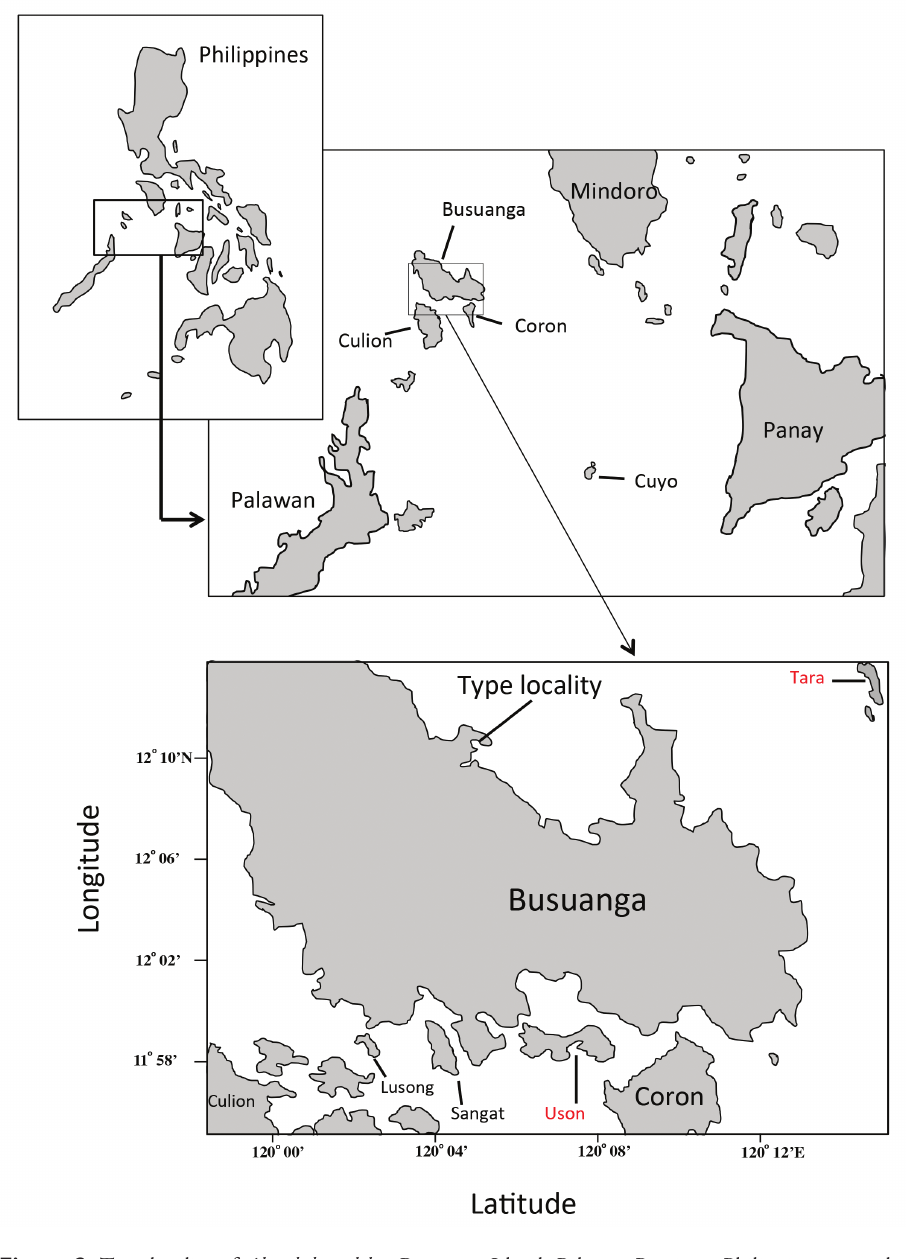
Figure 2. Type locality of Altrichthys alelia . Busuanga Island, Palawan Province, Philippines, near the village of Maricaban, next to the resort “El Rio y Mar”, 12.1911°N; 120.1022°E. Highlighted in red are Tara Island and Uson Island, where specimens of Altrichthys were first collected, as well as Uson Island and Sangat Island where sister species A. azurelineatus and A. curatus were